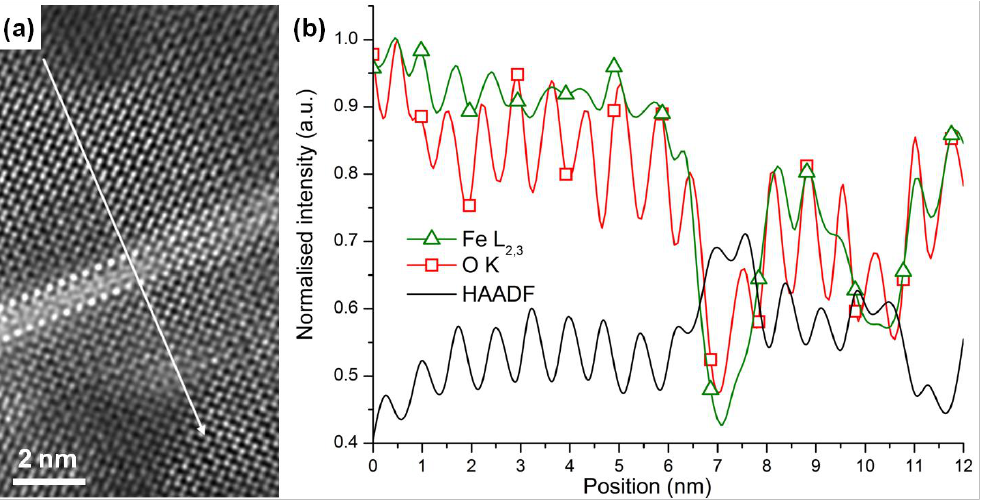
Figure 5. EELS line scan inside the Fe O , across the stripe. (a) Z-contrast image, 2 3 indicating the points from where the EEL spectra were acquired and (b) integrated Fe and O intensity as a function of probe position, along with the simultaneously acquired HAADF signal (green line with triangle markers, red line with square markers and solid black line respectively). The Fe-L edge (res. O-K edge) was integrated over a 60 eV 2,3 (resp. 50 eV) window above its edge onset. In both cases, the background was removed using a power law